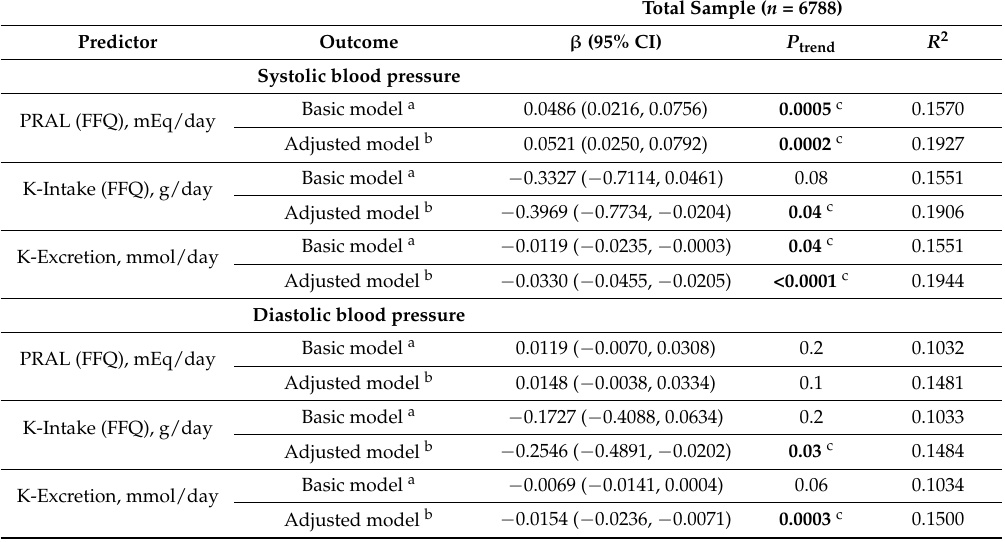
Table 2. Multiple linear regression analyses on the association of PRAL and potassium in sex-balanced quintiles as continuous predictor variables with blood pressure levels as continuous outcome variables in the total DEGS1 study sample ( n = 6788).